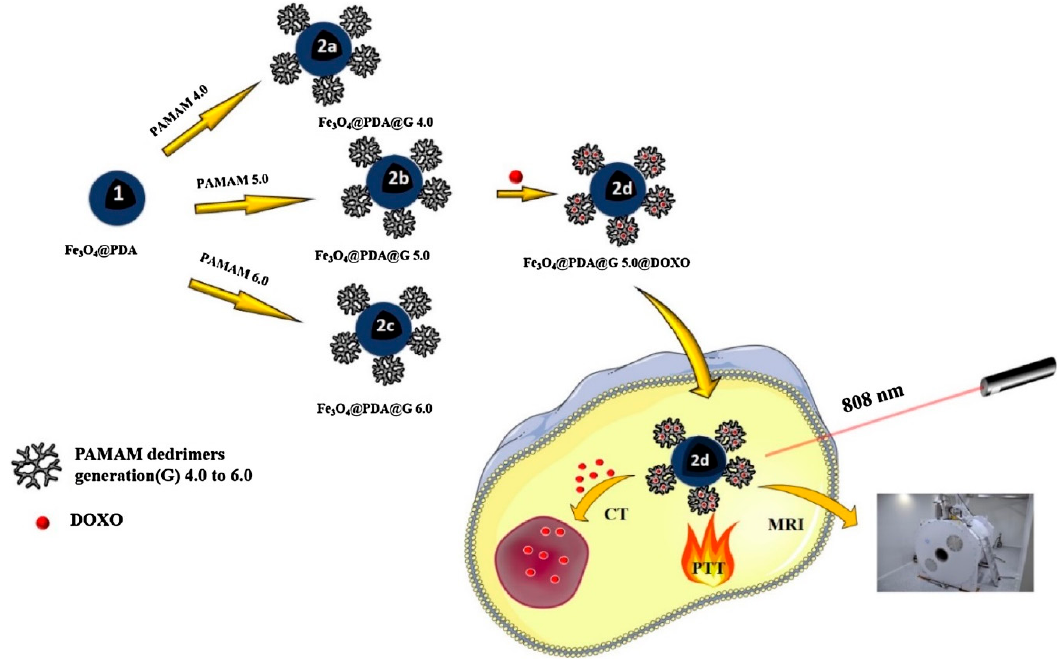
Figure 5. The schematic synthesis presentation of theranostic nanoplatform based on the Fe3O4@PDA@G 4.0–6.0 nanoparticles and its application in combined CT-PTT therapy on